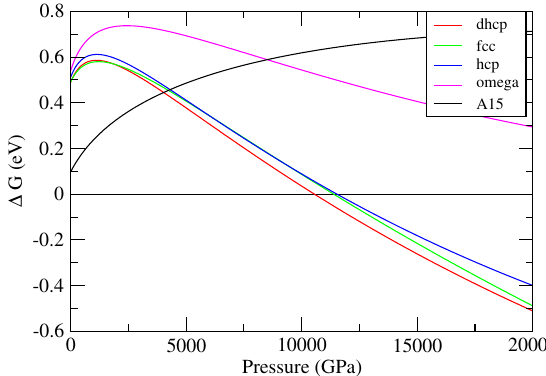
Figure 6. The T = 0 free energies of different solid structures of W (listed in the legend) from ab initio calculations using VASP (Vienna Ab initio Simulation Package): The free energy of bcc-W is taken to be identically